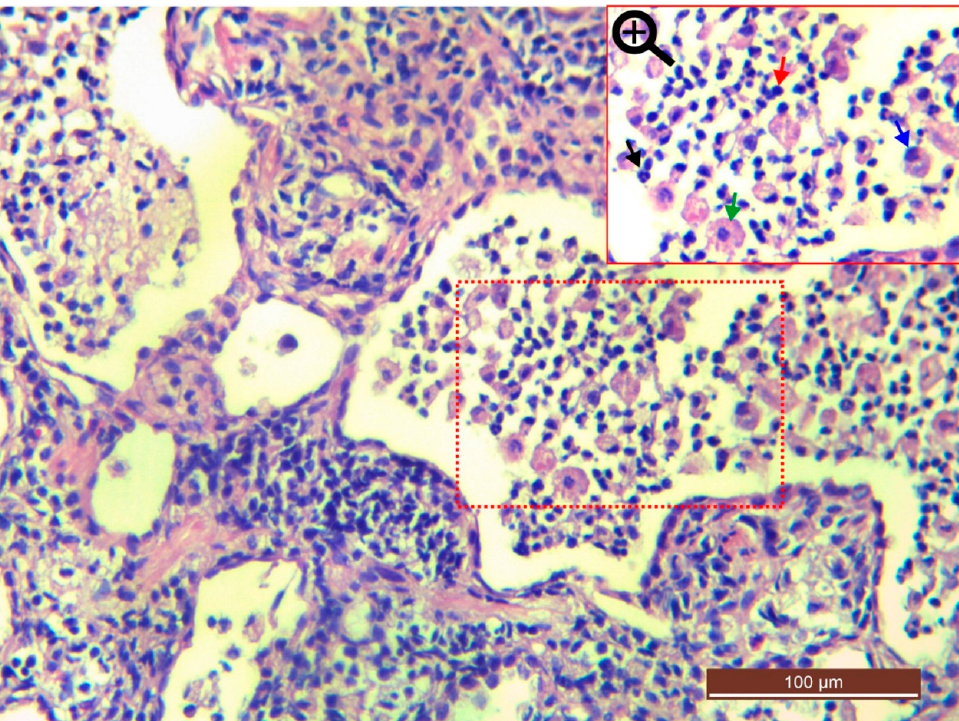
Figure 19. Bronchopneumonia due to R. equi . Photomicrograph of Cat 25 indicates exudate (combination of inflammatory cells and proteinaceous material) in the alveoli. The focused section (red dotted square) has been magnified and indicates a variety of cellularity such as macrophage (green arrow), neutrophil (black arrow), lymphocyte (red arrow) and plasma cell (blue arrow).